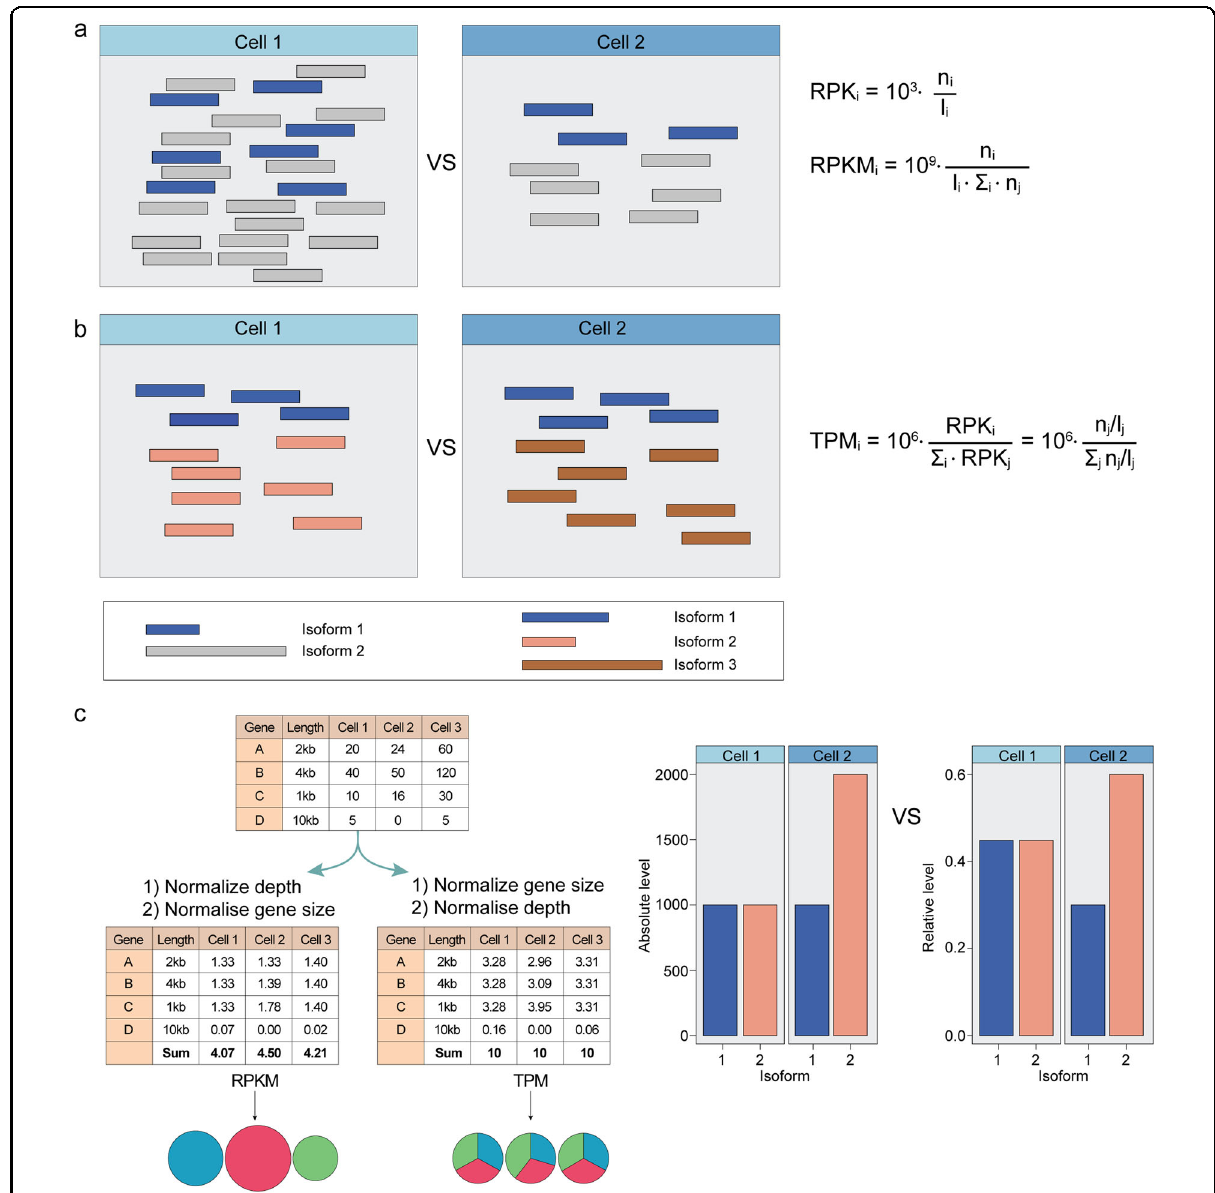
Fig. 3 Methods for the quanti fi cation of expression in scRNA-seq. a Reads per kilobase (RPK) is de fi ned by multiplying the read counts of an isoform (i) by 1000 and dividing by isoform length. Reads per kilobase per million (RPKM) is de fi ned to compare experiments or different samples (cells) so that additional normalization by the total fragment count is integrated in the denominator term, which is expressed in millions. b The metric TPM takes other isoforms into account, which contrasts with the RPKM metric. This metric quanti fi es the abundance of isoforms (i) using the RPK fraction across isoforms. c A schematic example illustrates the difference between the RPKM and TPM measures 53 . TPM is ef fi cient for measuring relative abundance because total normalized reads are constant across different cells. d However, we should be careful to interpret the fact that differentially expressed genes can be falsely annotated as a result of overexpression of the other